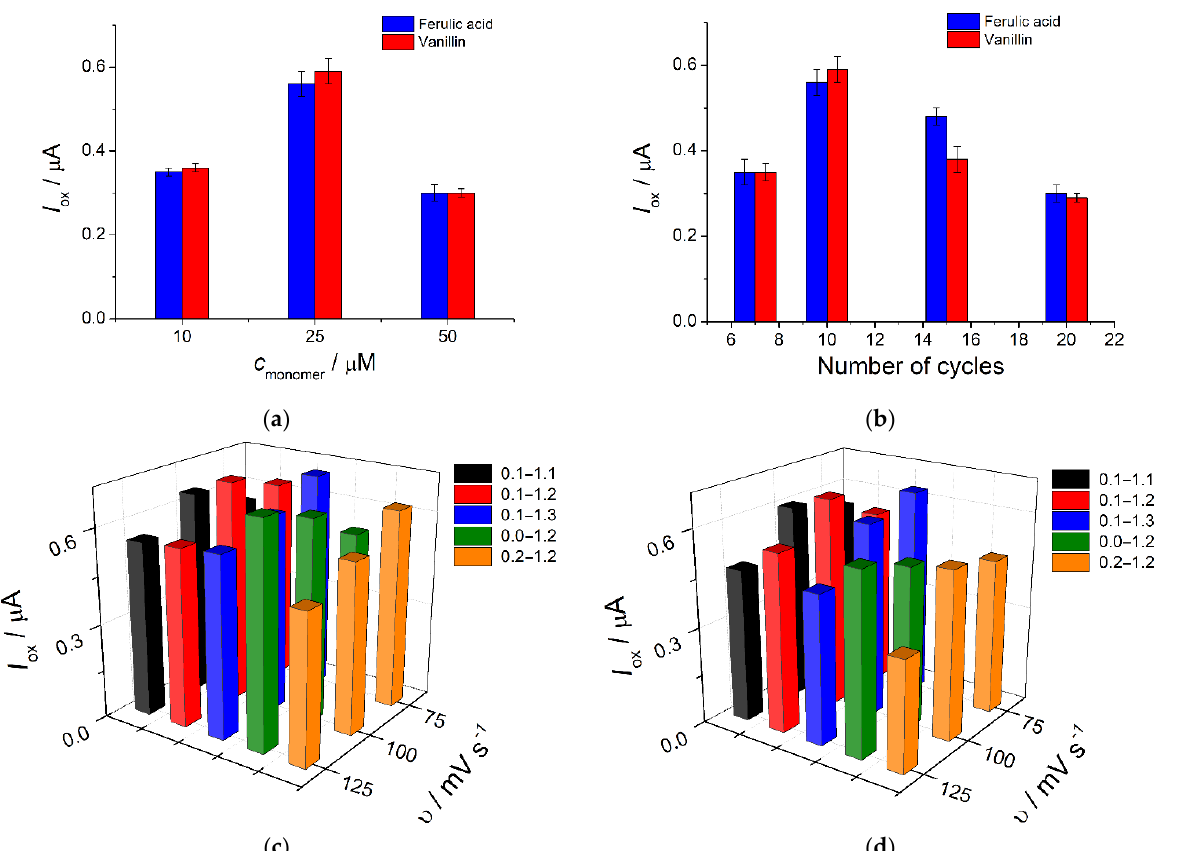
Figure 4. Effect of bromocresol purple electropolymerization conditions on the oxidation currents of 10 µM mixture of ferulic acid and vanillin. ( a ) Effect of monomer concentration: polarization window, 0.0 – 1.0 V; υ = 100 mV s ‒ 1 . ( b ) Effect of number of cycles: polarization window, 0.0 – 1.0 V; υ = 100 mV s ‒ 1 ; c monomer = 25 µM. ( c ) Effect of polarization window and potential scan rates on the oxidation currents of ferulic acid: number of cycles, 10; c monomer = 25 µM. ( d ) Effect of polariza- tion window and potential scan rates on the oxidation currents of vanillin: number of cycles, 10; c monomer = 25 µM.